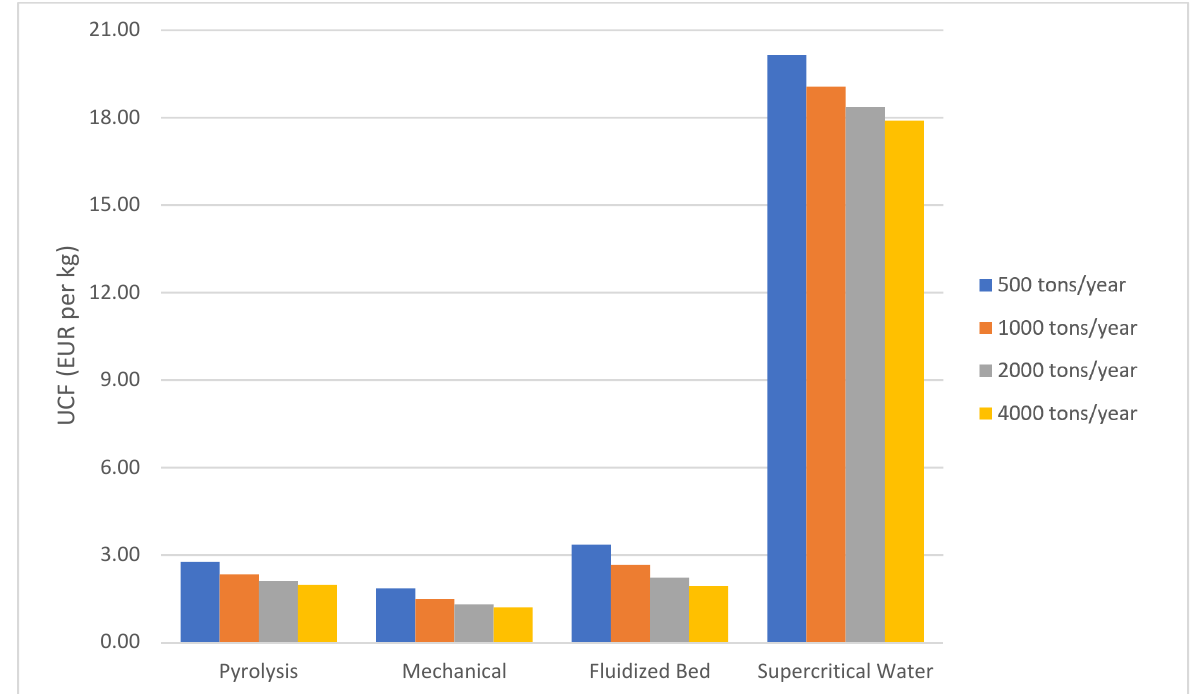
Figure 6. Unit cost per mass of recovered carbon fiber at 100% recovery rate.